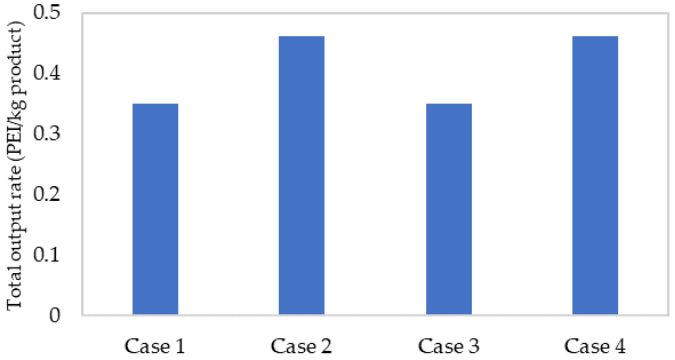
Figure 6. Total PEI output for crude palm oil production process, adapted from [10].